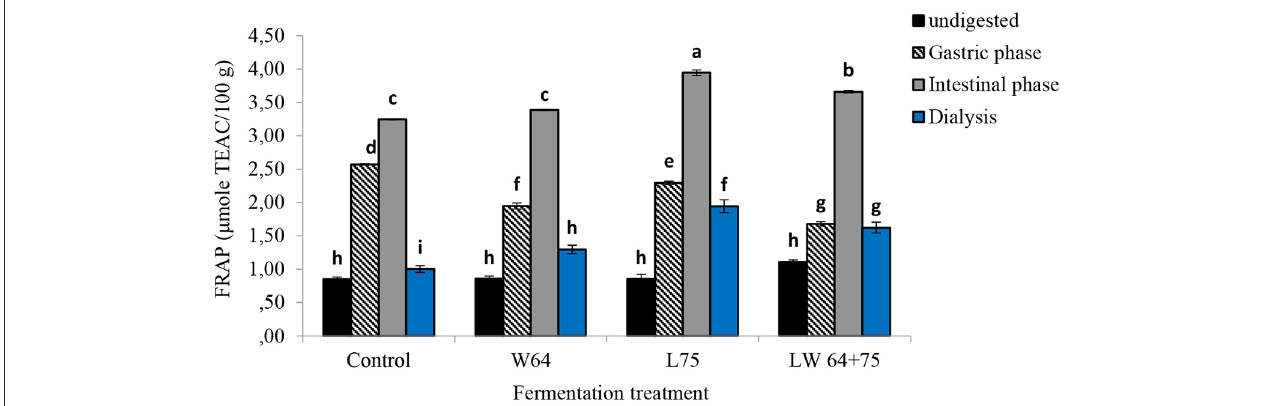
FIGURE 8 | Ferric ion reducing antioxidant power (FRAP) of LAB fermented smoothies subjected to gastrointestinal digestion and dialysis. Bars with similar alphabetic letters for a specific digestive phase are not significantly different at p < 0.001 level. W64, Weissella cibaria 64; L75, Lactobacillus plantarum 75; LW64 + 75, W. cibaria 64 + L. plantarum 75; DW, dry weight; control, non-fermented